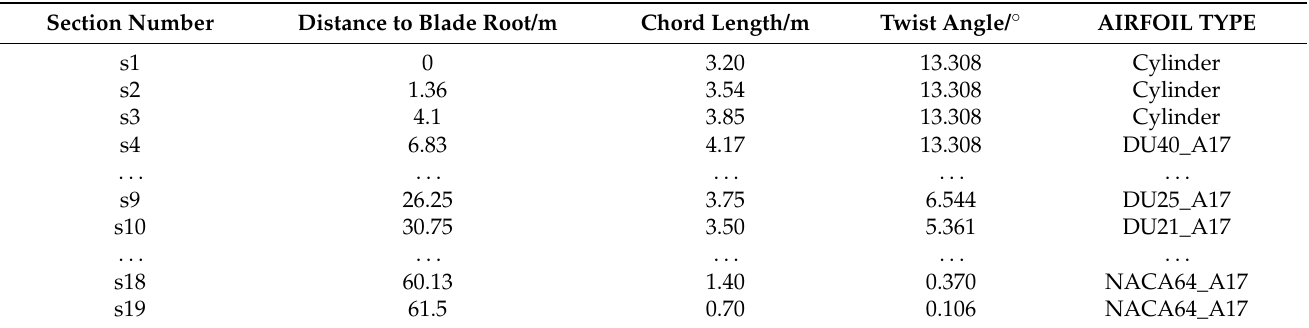
Table 1. Main geometrical features of the 5 MW wind turbine blade